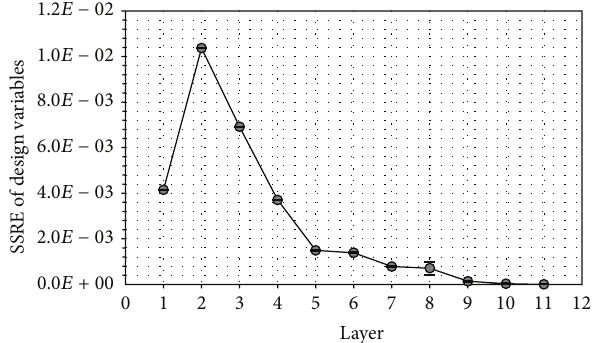
Figure 14: History of the accuracy of the approximated objective function